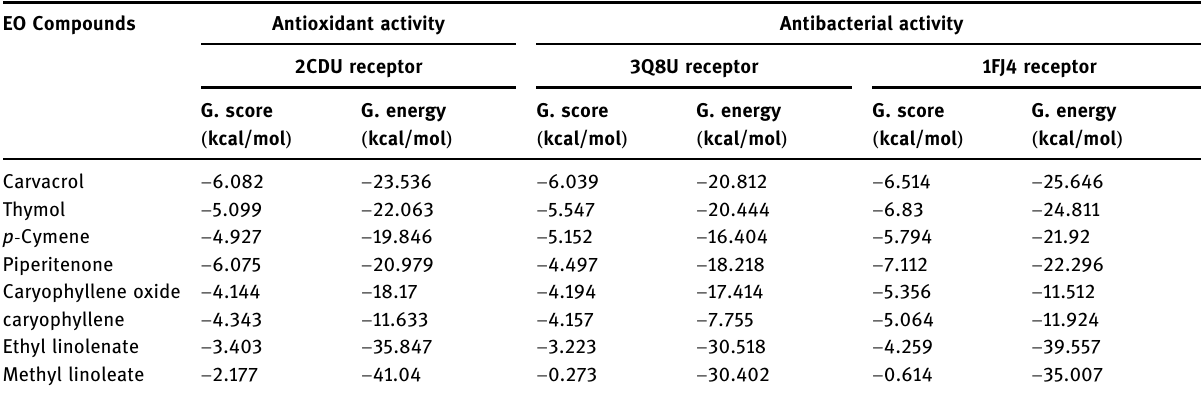
Table 5: Docking results of O. compactum in active site of NADPH ( PDB: 2CDU ) , S. aureus nucleoside diphosphate kinase ( PDB: 3Q8U ) , and E. coli beta - ketoacyl -[ acyl carrier protein ] synthase ( PDB: 1FJ4